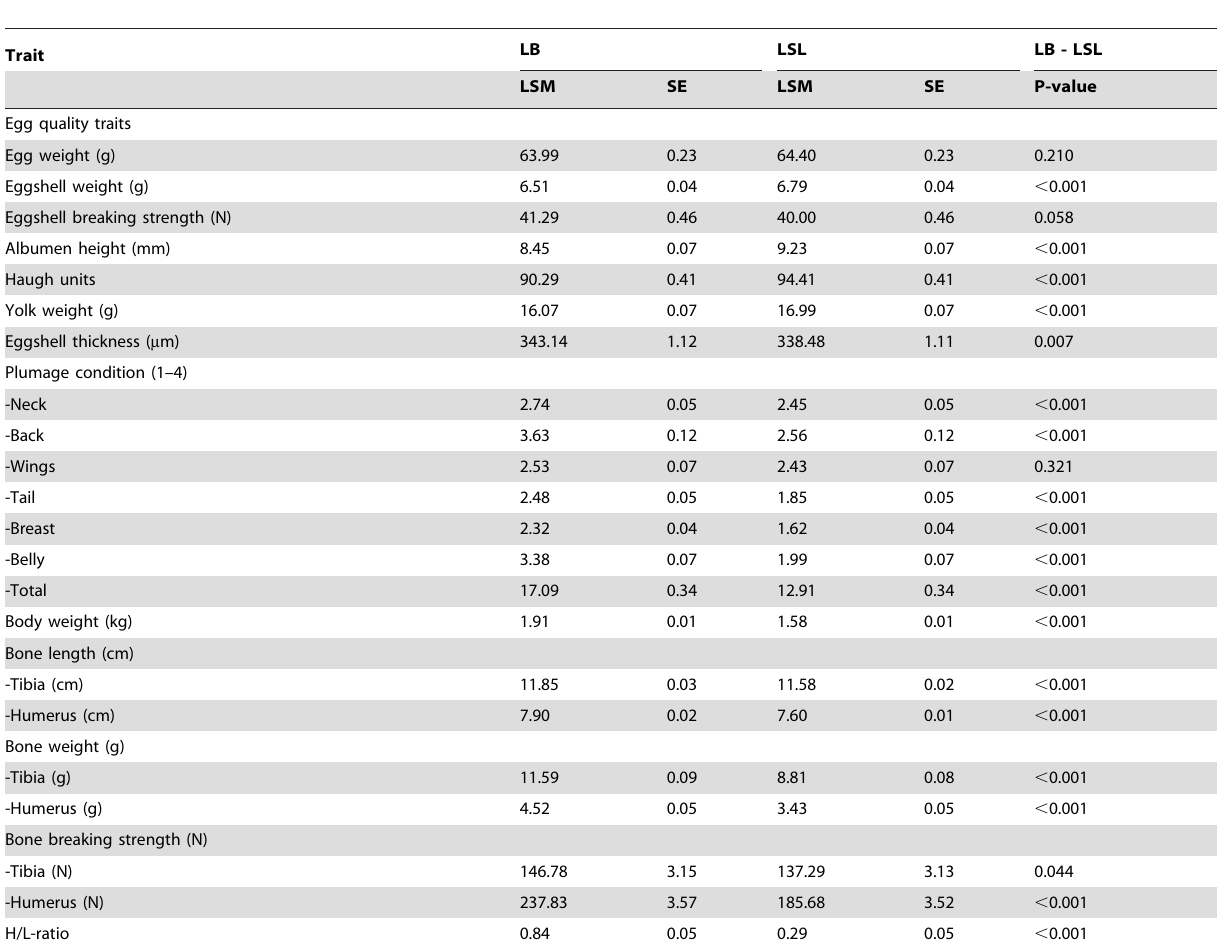
Table 1. Least-square means (LSM), their standard errors (SE) and P-values for the phenotypic traits analysed in the two layer lines Lohmann Selected Leghorn (LSL) and Lohmann Brown